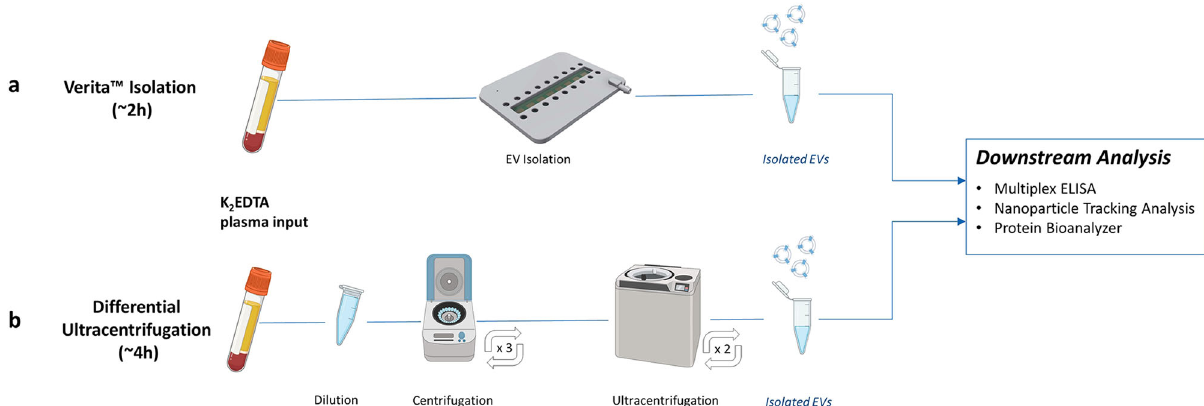
Fig. 1 Schematic showing EV isolation work fl ows using either Verita ™ or ultracentrifugation methods. a Work fl ow using the Verita ™ Isolation platform. As plasma samples are fl owed onto the energized AC Electrokinetics (ACE) microelectrode array, EVs are collected onto the electrodes. Unbound materials are removed with a buffer wash, the electric fi eld turned off, and EVs are eluted into the buffer. b Work fl ow for differential ultracentrifugation. Plasma samples are diluted, and large debris pelleted by a low-speed centrifugation step. Supernatants are removed and subjected to two additional cycles of low-speed centrifugation. EVs in the cleared supernatants are then ultracentrifuged two times, and lastly the pellet is resuspended